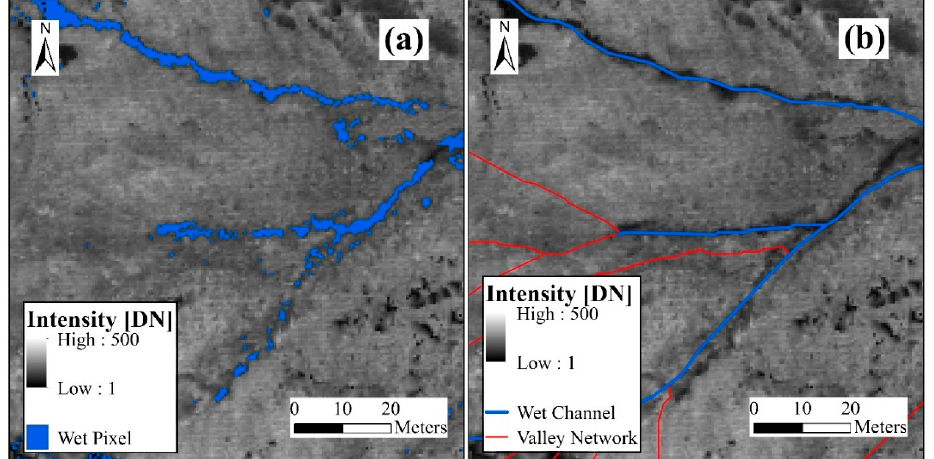
Figure 4. The identified wet pixels and the connected wet channel network with the valley network. ( a ) The identified wet pixels based on the intensity thresholds. ( b ) The connected wet channel network with the valley network after processing isolated wet channel segments based on the 2012 LiDAR survey in the Ward Creek watershed [DN: digital number].